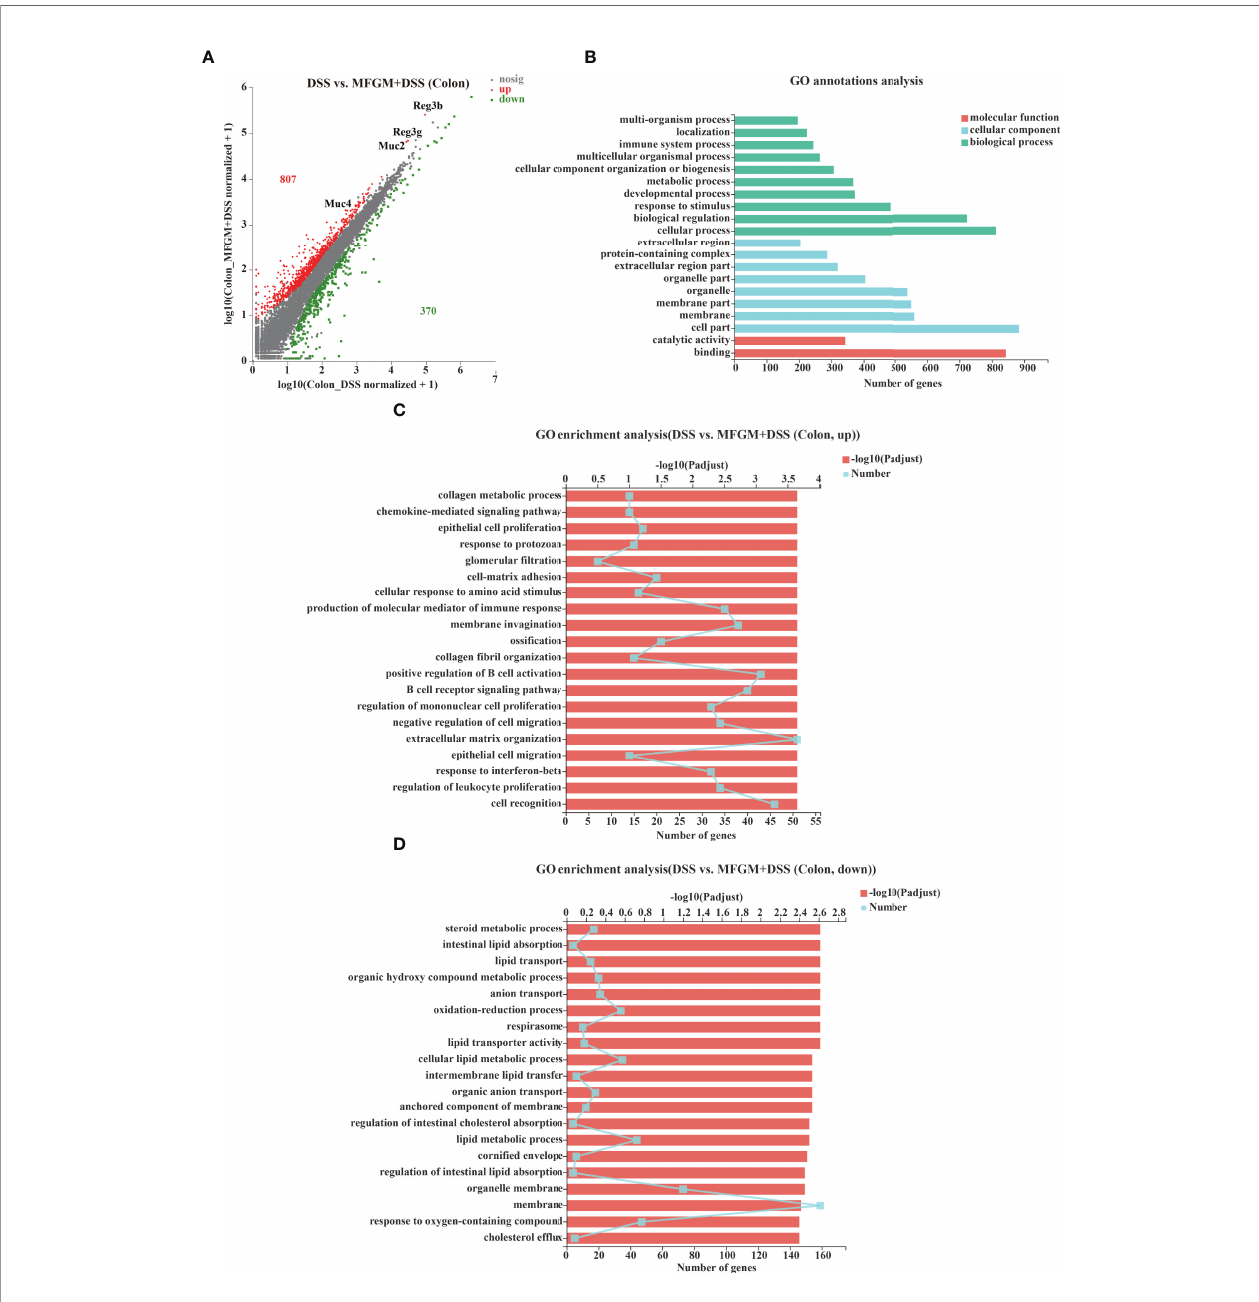
FIGURE 2 | Milk fat globule membrane (MFGM) impacted the colonic gene expression pro fi les in dextran sulfate sodium (DSS)-treated mice. (A) Scatter diagram of the differentially expressed genes in the comparison. The red point denotes an upregulated gene in the MFGM + DSS group, while the green point denotes a downregulated gene in the MFGM + DSS group compared with the DSS group. The gray point denotes an insigni fi cantly expressed gene in the comparison. (B) Gene Ontology (GO) annotation analysis of the differentially expressed genes in the comparison of the colon. GO enrichment of the upregulated genes (C) and the downregulated genes (D) in the comparison of the